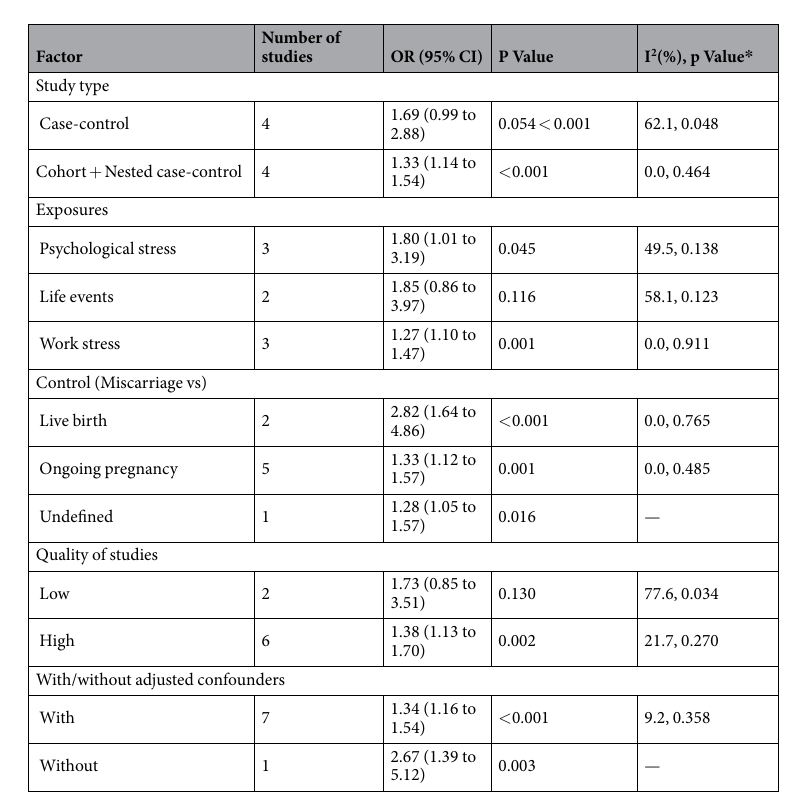
Table 2. Results of subgroup analyses. Note: OR: Odds Ratio; CI: confidence interval; * p Value for